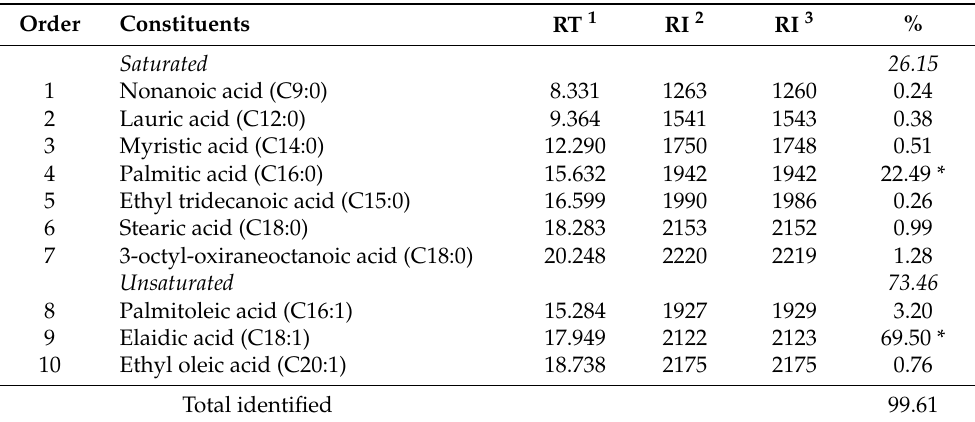
Table 1. Fatty acids in the fixed oil of Hancornia speciosa seed identified by gas chromatography/mass spectrometry (GC/MS), after obtaining corresponding methyl esters.